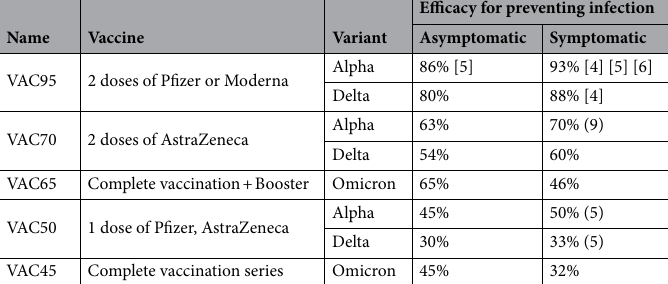
Table 2. Permutations of vaccination efficacy in workplace